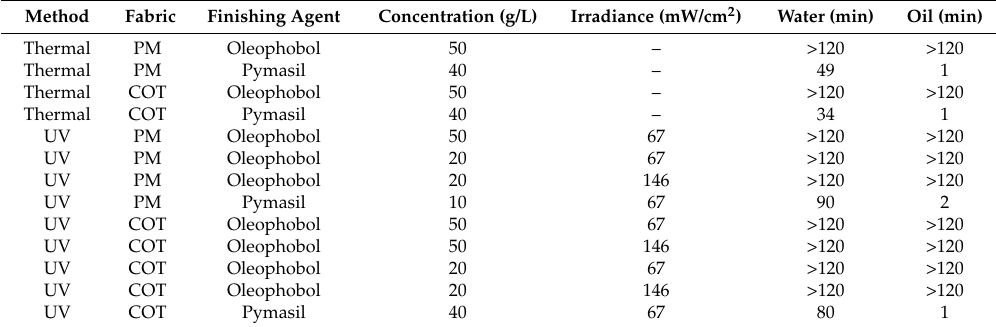
Table 1. Absorbency of drops on treated